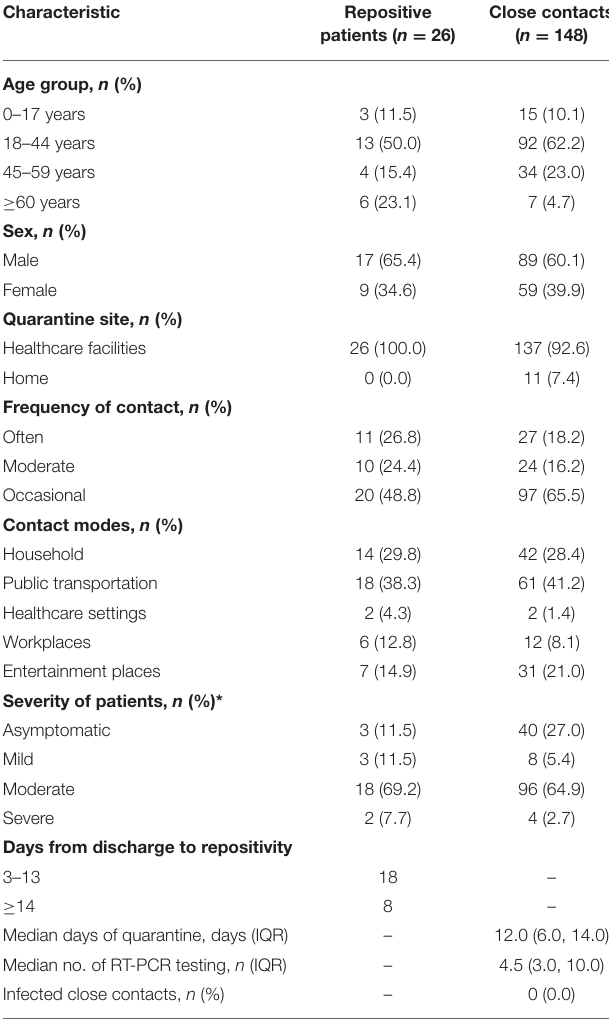
TABLE 4 | Characteristic of repositive patients and the close